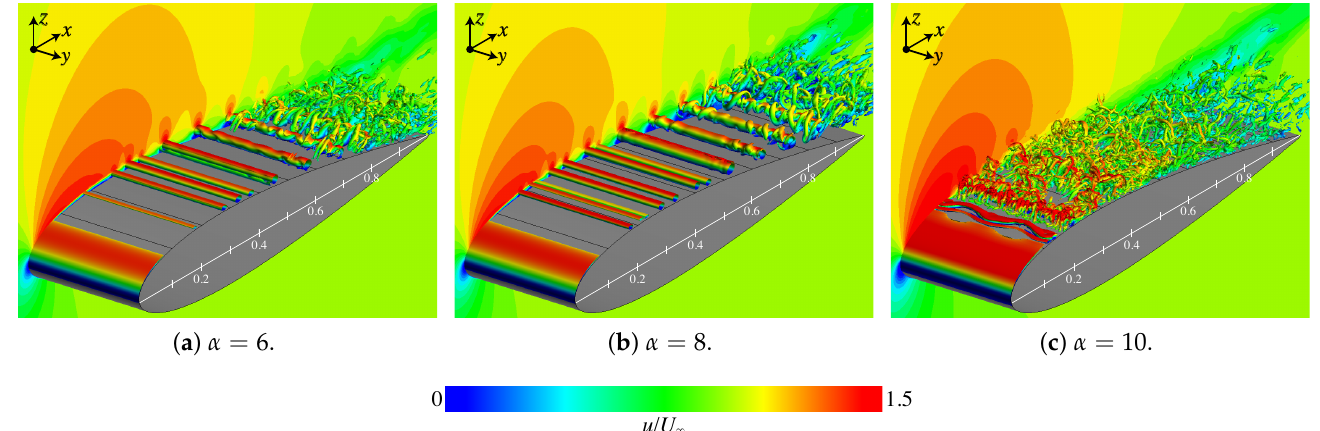
Figure 16. Instantaneous flows with the isosurface of the second invariant of the velocity gradient tensor colored with the chordwise velocity ( u / U ∞ ) in the Burst